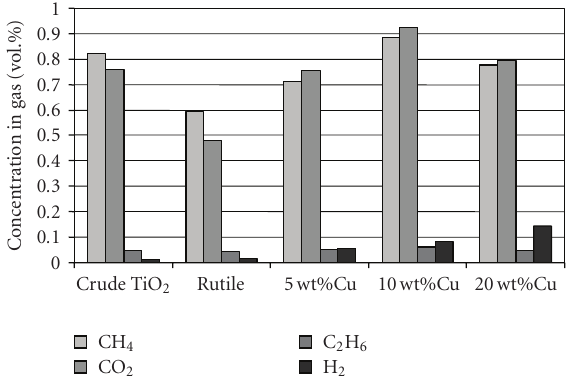
Figure 4: A comparison of the amount of products obtained after 5 hours of reaction conducted with di ff erent photocatalysts.